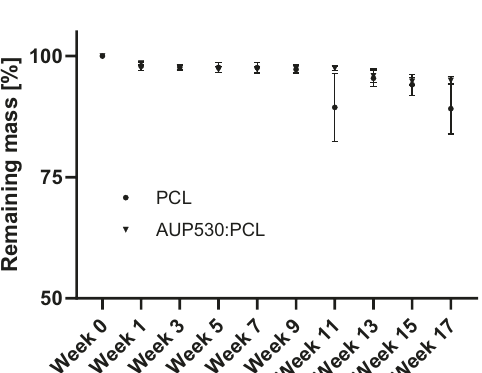
Table 4 Overview of the tensile testing data of the non- reinforced, drug-loaded versus reinforced, drug-loaded repair constructs (AUP compared to PCL as a reference) on ex vivo sheep tendons